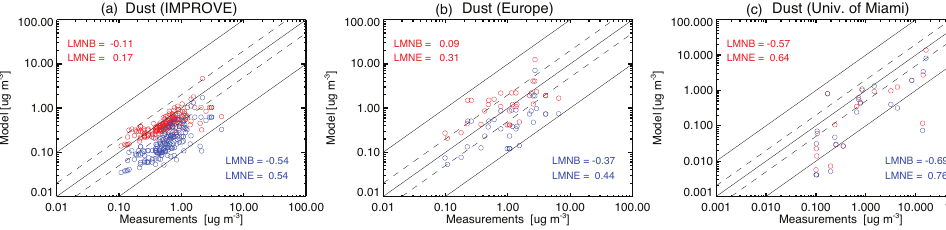
Figure 12. Same as Fig. 8 but for dust mass concentrations.